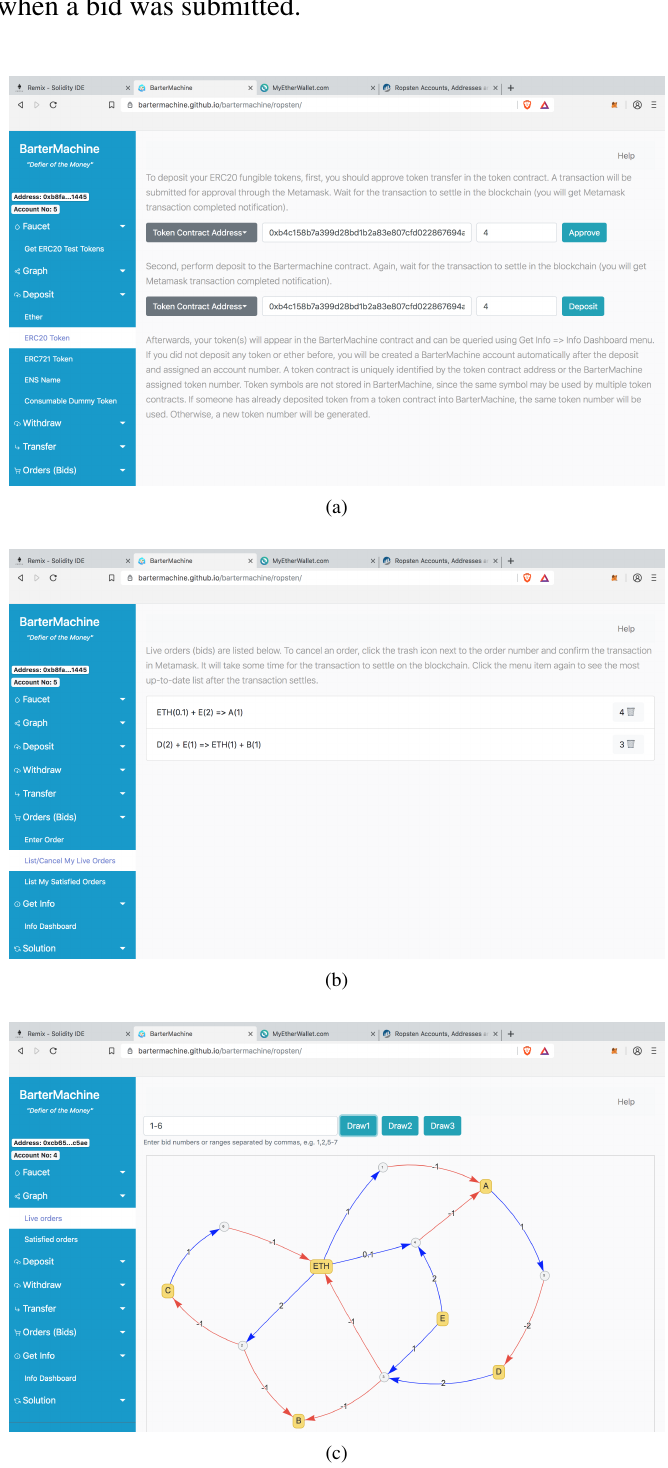
Fig. 3. BarterMachine web user interface ; deposit (a), orders listing (b), and graph (c)